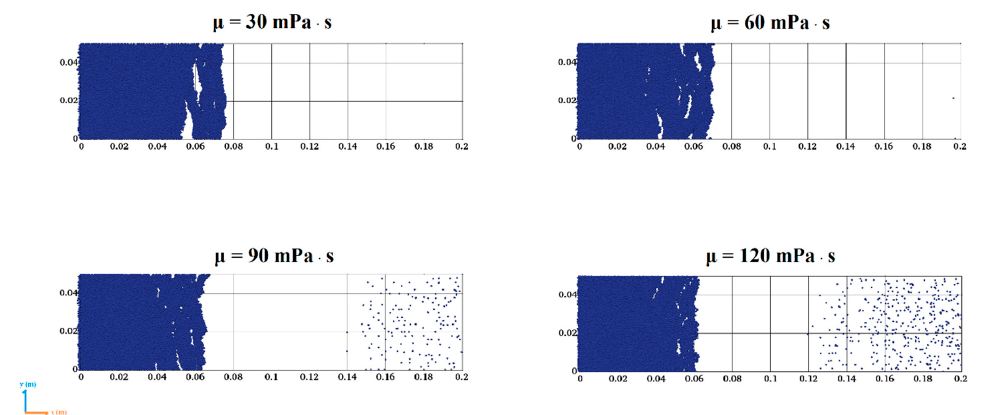
Figure 5. Successful fracture sealing of the four most viscous fluids.